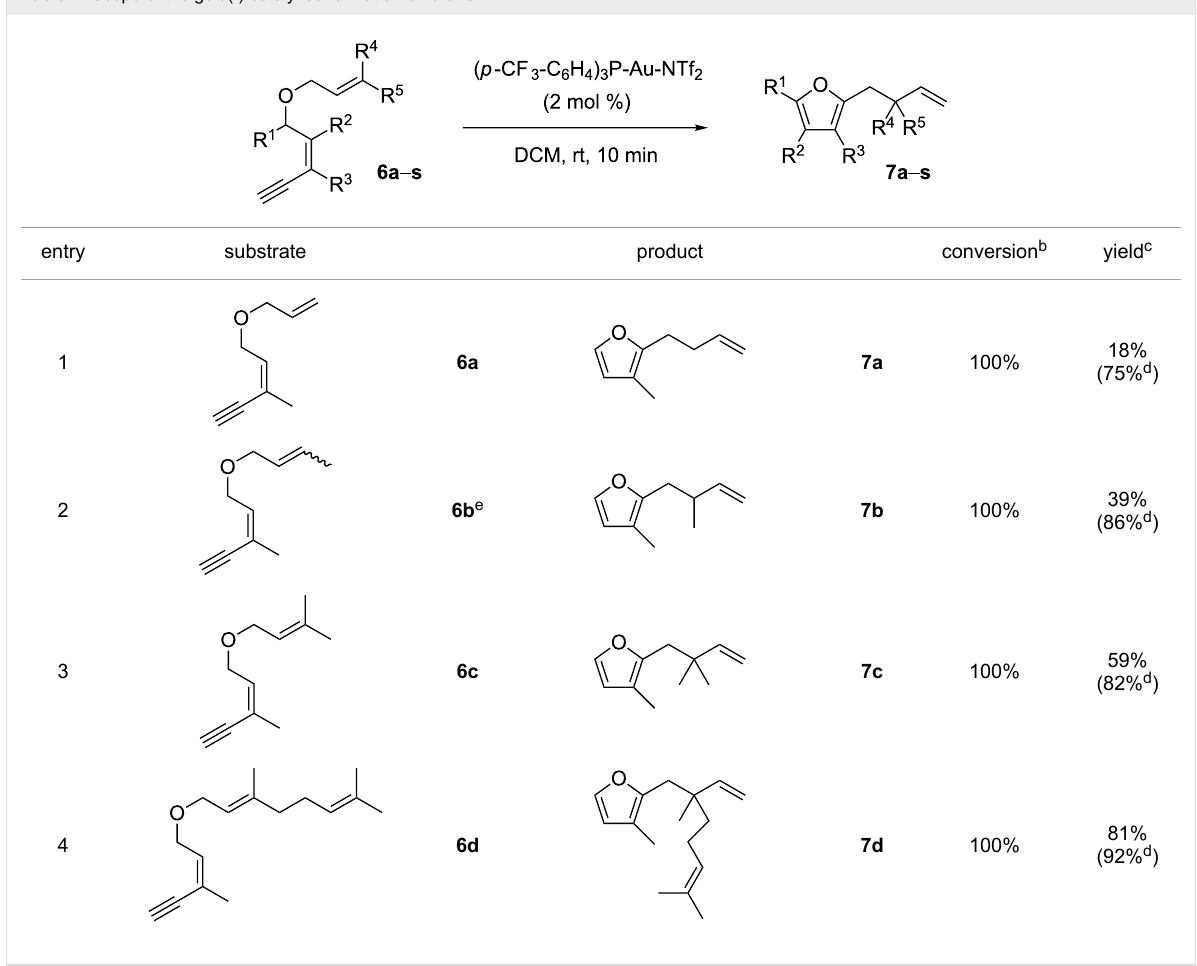
Table 1: Scope of the gold(I)-catalyzed formation of furans. a